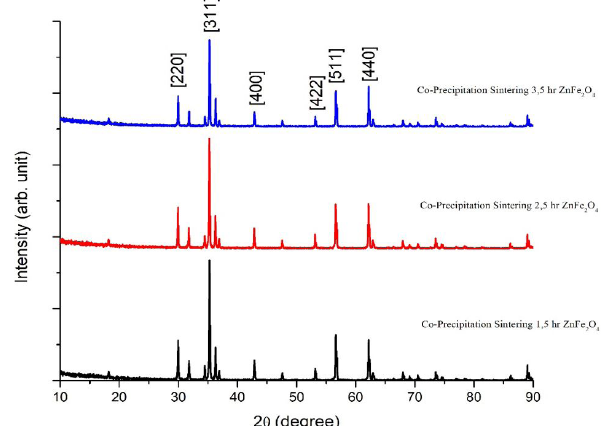
O sintered for (a) 1.5 h, (b) 2.5 h and (c) 3.5 h; all images are at 100,000× magnification. 2 4